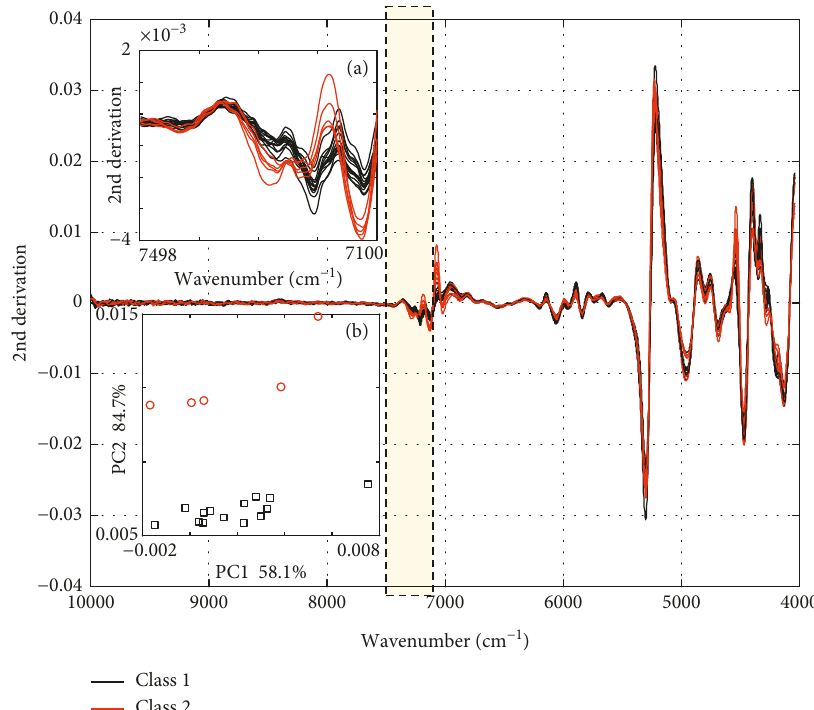
Figure 4: Comparison of Class 1 and 2 in the spectral space and principal component space. (a) The 2nd derivative preprocessed spectra of Class 1 and 2 between 7100cm − 1 and 7498cm − 1 . (b) The first and second scores of Class 1 and 2 using the 2nd spectra between 7100cm − 1 and 7498cm − 1